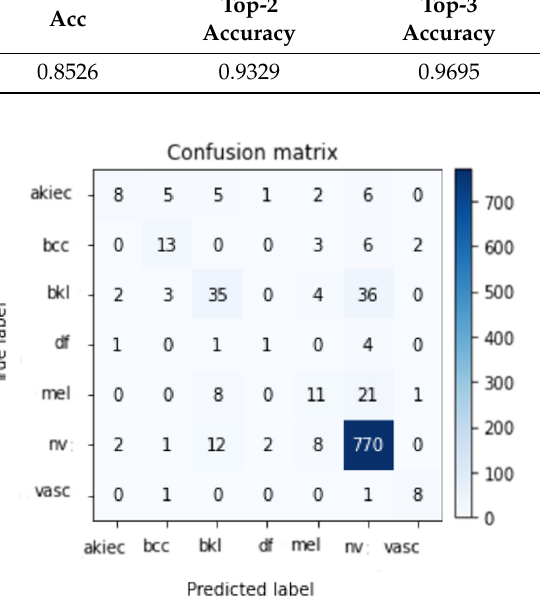
Figure 11. Best confusion matrix of CNN.